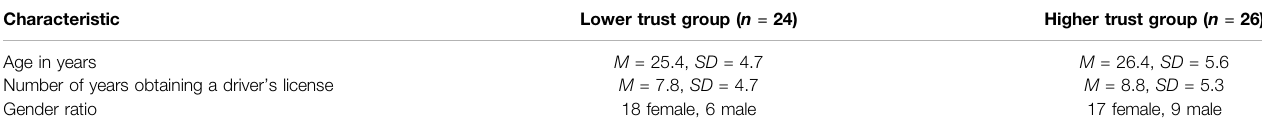
TABLE 1 | Demographics of the two trust groups within the sample ( N (cid:1) 50). Characteristic